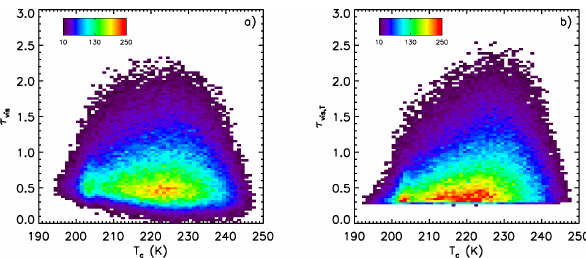
Figure 12. Two-dimensional histogram of lidar ratio (a) S cal ( η = 0.6) and (b) S cal , T ( η T from this study) and centroid tempera- ture T c . The color code is the number of samples. The black solid line is the median value. The dotted lines indicate minimum and maximum values and associated temperatures (see text). Same data set as in Fig.